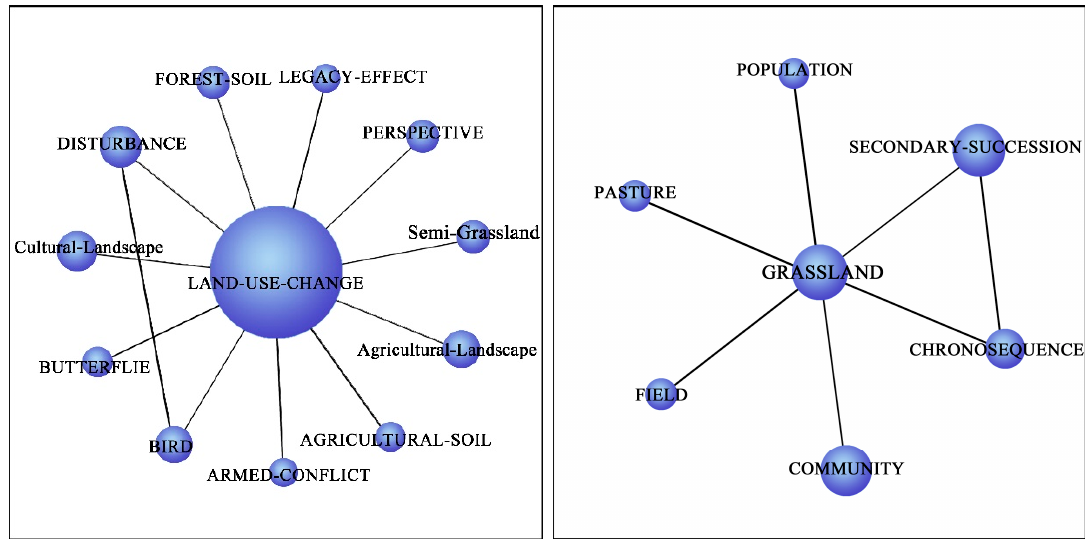
Figure 12. Land-use-change and grassland-cluster network map.